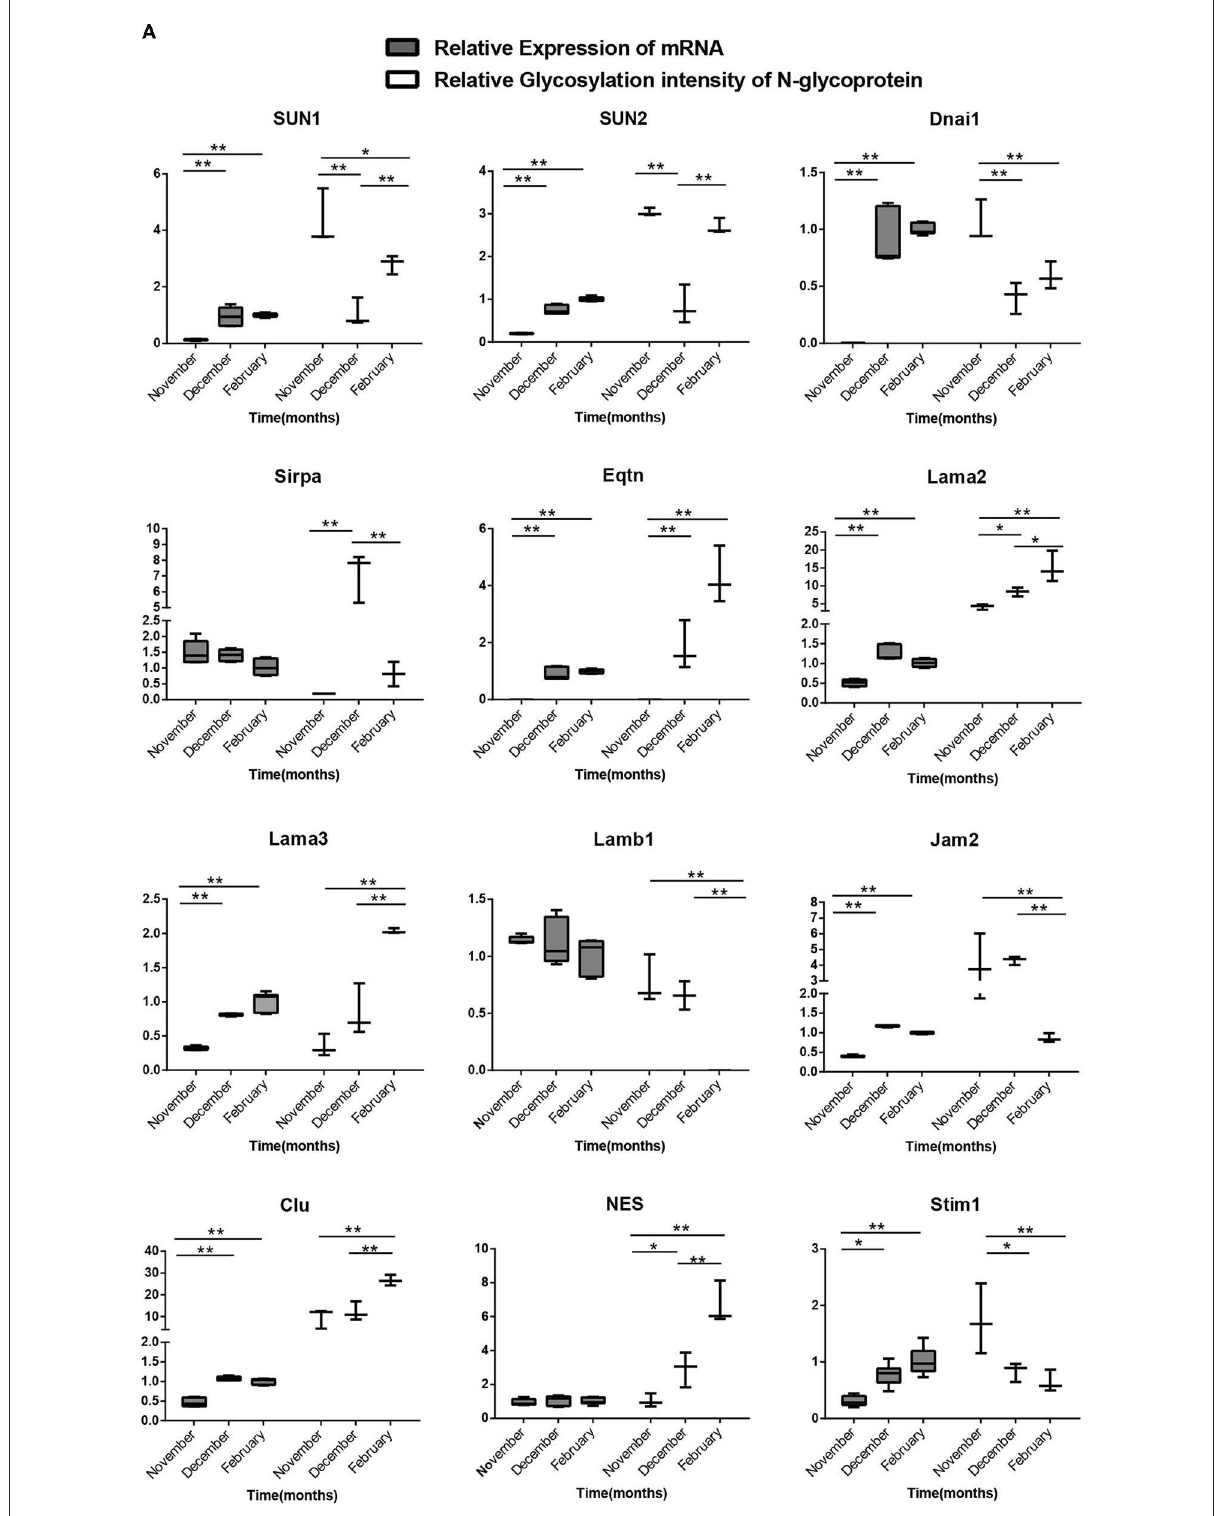
FIGURE8A Relationship between the transcription levels of different N-glycosylated protein genes in different stages of spermatogenesis and the relative ionic strength of different N-glycosylated peptides in the corresponding proteins. One-way ANOVA with Tukey post hoc test was used for data statistics. Data are presented as mean with 95% CI. P < 0.05 was considered significant. * p < 0.05, ** p <